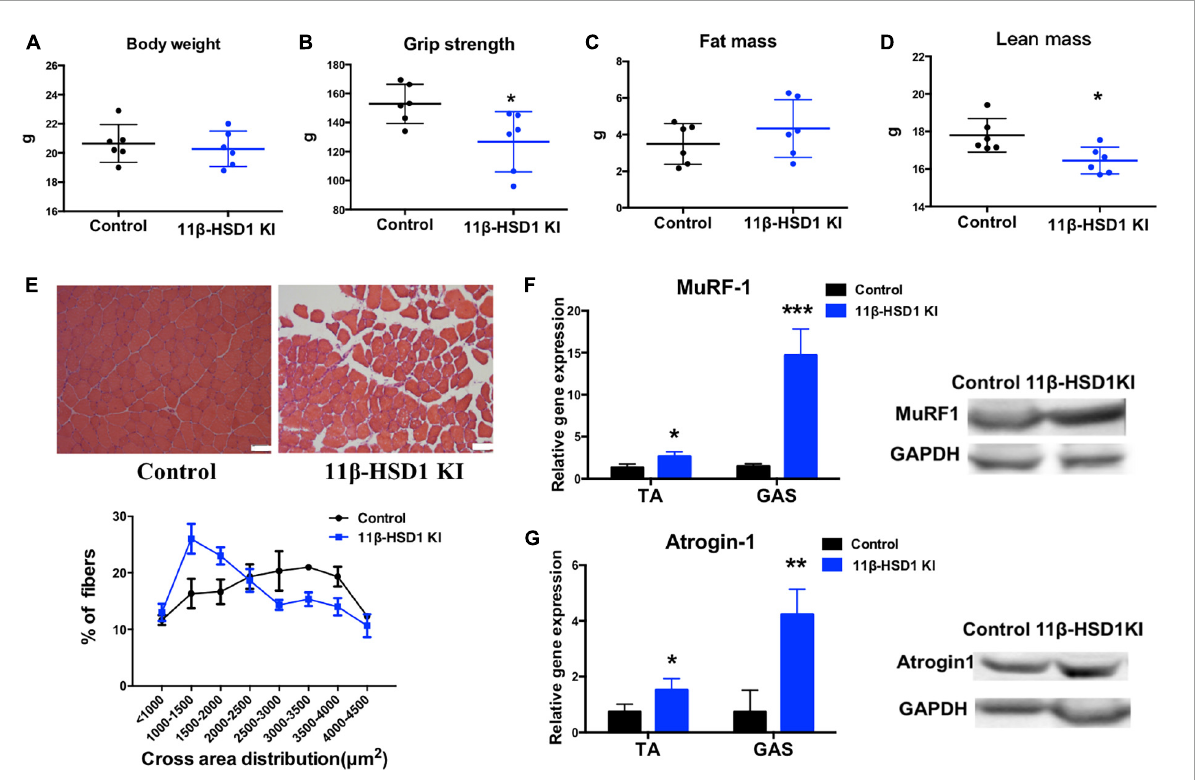
FIGURE3 Overexpression of 11 β -HSD1 leads to muscle atrophy in young mice. (A) Body weight of 11 β -HSD1 KI mice and control mice ( n = 6 mice per group) at 2 months of age. (B) Muscle strength of 11 β -HSD1 KI mice and control mice ( n = 6 mice per group). (C) Fat mass of 11 β -HSD1 KI mice and control mice ( n = 6 mice per group). (D) Lean mass of 11 β -HSD1 KI mice and control mice ( n = 6 mice per group). (E) Representative HE staining images of muscle cross sections derived from 11 β -HSD1 KI mice and control mice. Scale bars, 50 µ m. Percentage distribution of muscle fiber cross-sectional area derived from muscles. (F,G) mRNA and protein levels of the muscle atrophy factors atrogin-1 and MuRF-1 in both TA and GAS ( n = 6 mice per group). TA, Tibialis anterior muscle; GAS, gastrocnemius. * p < 0.05, ** p < 0.01, *** p <